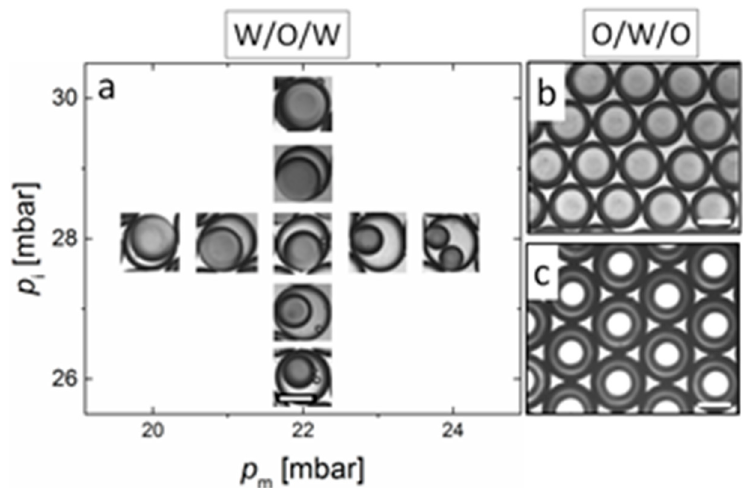
Figure 3. ( a ) Phase diagram for W/O/W emulsions with varying pressures for inner p i and middle phase p m . p o was kept constant at 200 mbar. ( b ) monodisperse emulsions of O/W/O with large inner droplet obtained at p i =23 mbar, p m = 19 mbar and ( c ) monodisperse O/W/O emulsion with small inner droplet obtained at p i = 24 mbar, p m = 27 mbar. p o in ( a – c ) was set to 200 mbar. Scale bars represent 500 µm.